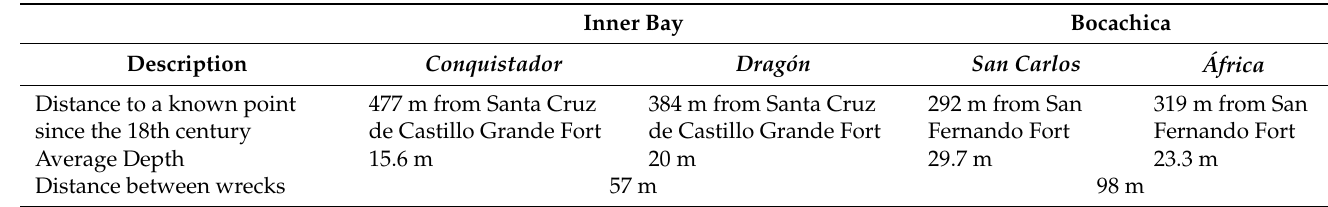
Table 5. Geographical description of the areas associated with the four